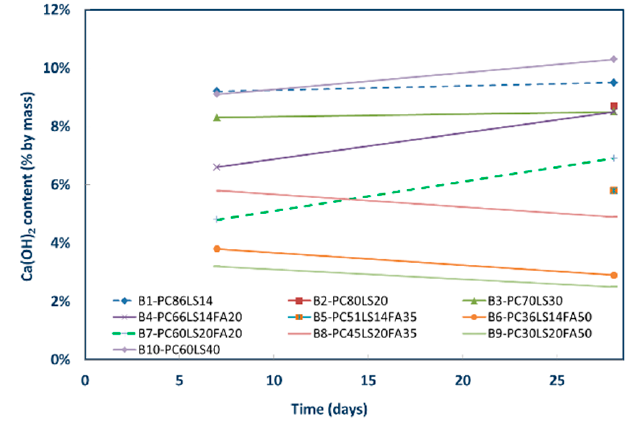
Figure 11. Ca(OH) 2 content of binary and ternary cementitious matrices.